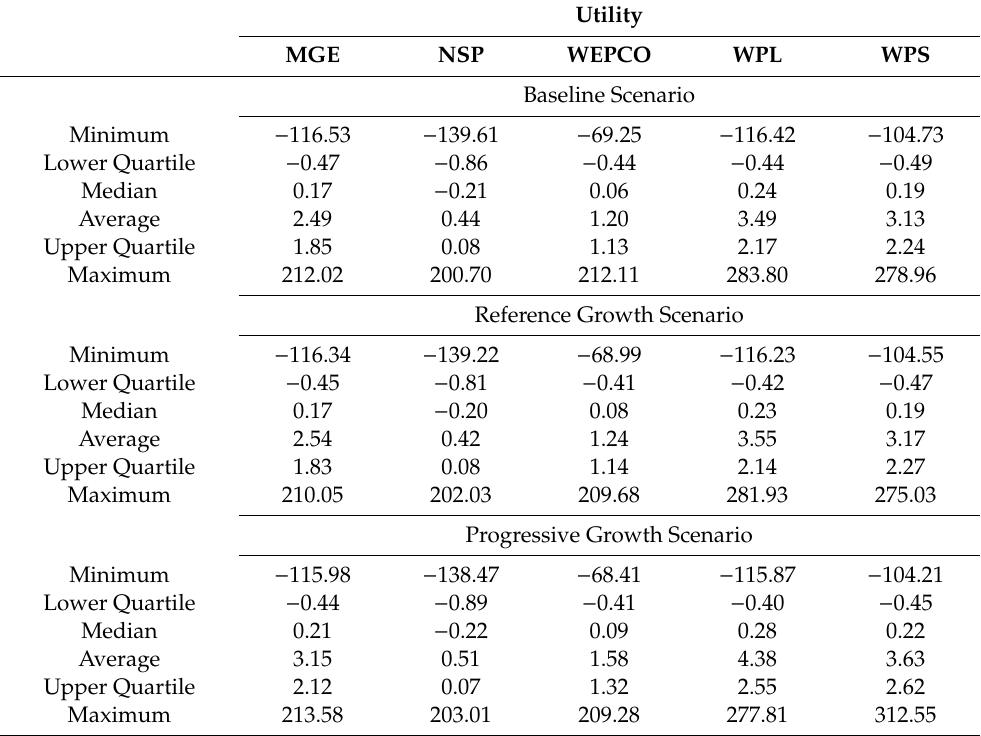
Table 5. Statistics of the modeled congestion component of hourly LMPS ($ / MWh) for each utility in Wisconsin in 2030 under the three growth